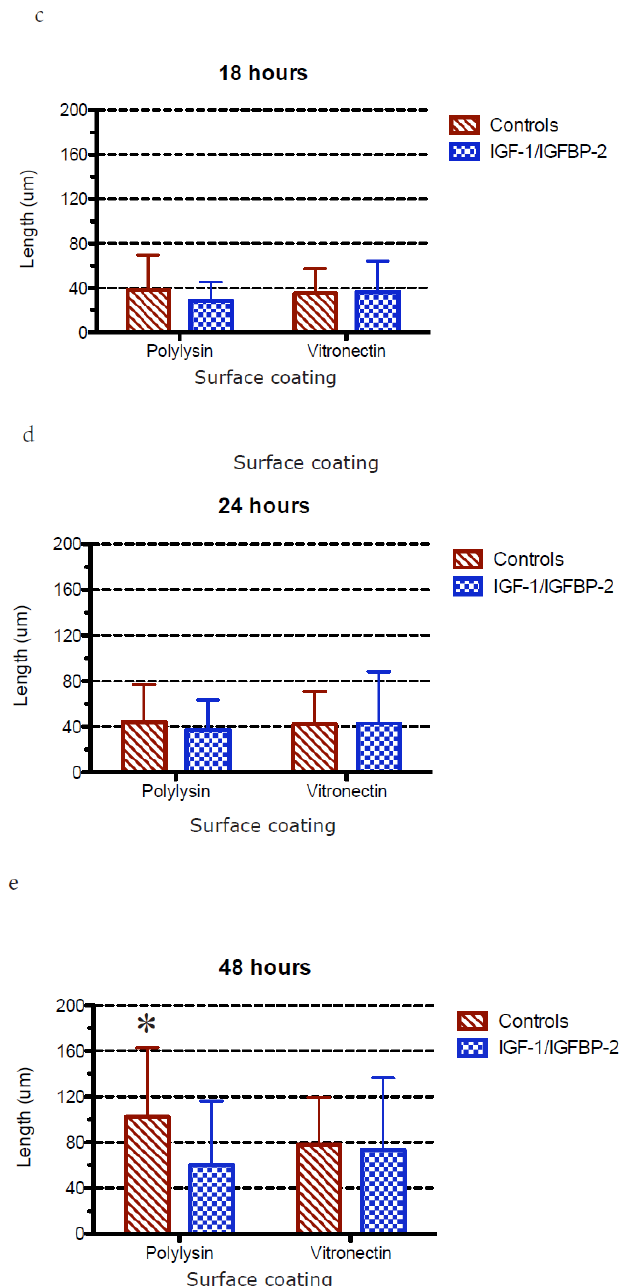
Figure 6. ( a )–( e ) The calculation of the longest neurite at different time points after injury. The length of the neurites was calculated as described in the methods section. Six wells for each treatment and time point were used for measurements and five cells per well were measured. Overall, no major differences were observed between growth on vitronectin and poly-L-lysin with or without treatment with IGF-1/IGFBP-2, except at later time points when growth on poly-L-lysin was found to be favorable both compared to vitronectin coating and to treatment with IGF-1/IGFBP-2. This is because, at 48 h, growth on poly-L-lysin showed statistically significant (*) longer neurites compared to growth on vitronectin both with and without IGF-1/IGFBP-2 treatment (one-way ANOVA with Bonferroni post hoc test, p <